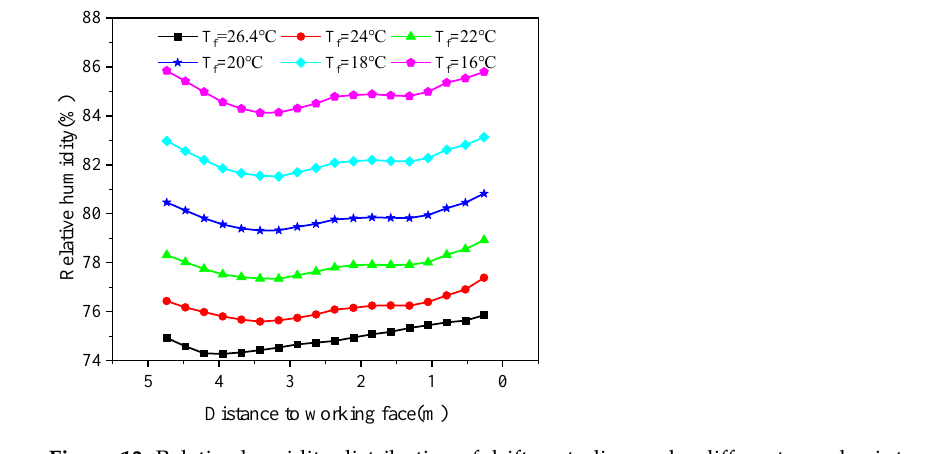
Figure 13. Relative humidity distribution of drift centerline under different supply air temperatures.